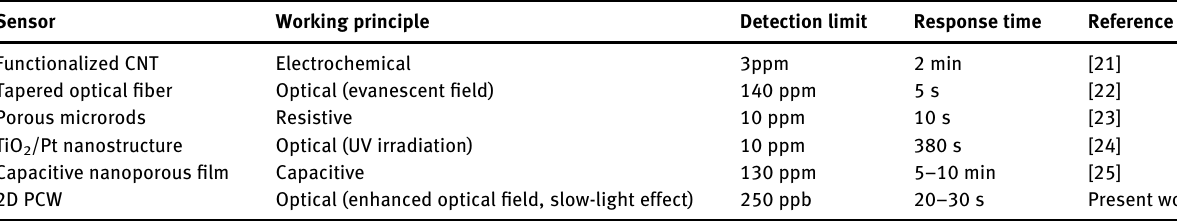
Table  : Performance comparison of ethanol sensors.